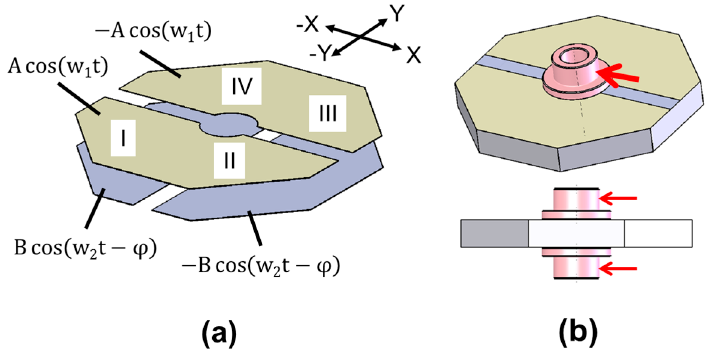
Figure 6. ( a ) Metallization electrodes are oriented orthogonally on the main surfaces of the octagonal piezoelectric plate. ( b ) The coupling elements are two eyelets that are attached in the middle of the two main surfaces on the octagonal piezoelectric plate. The side surfaces of the eyelets (marked with red arrows) are in contact with the slider.